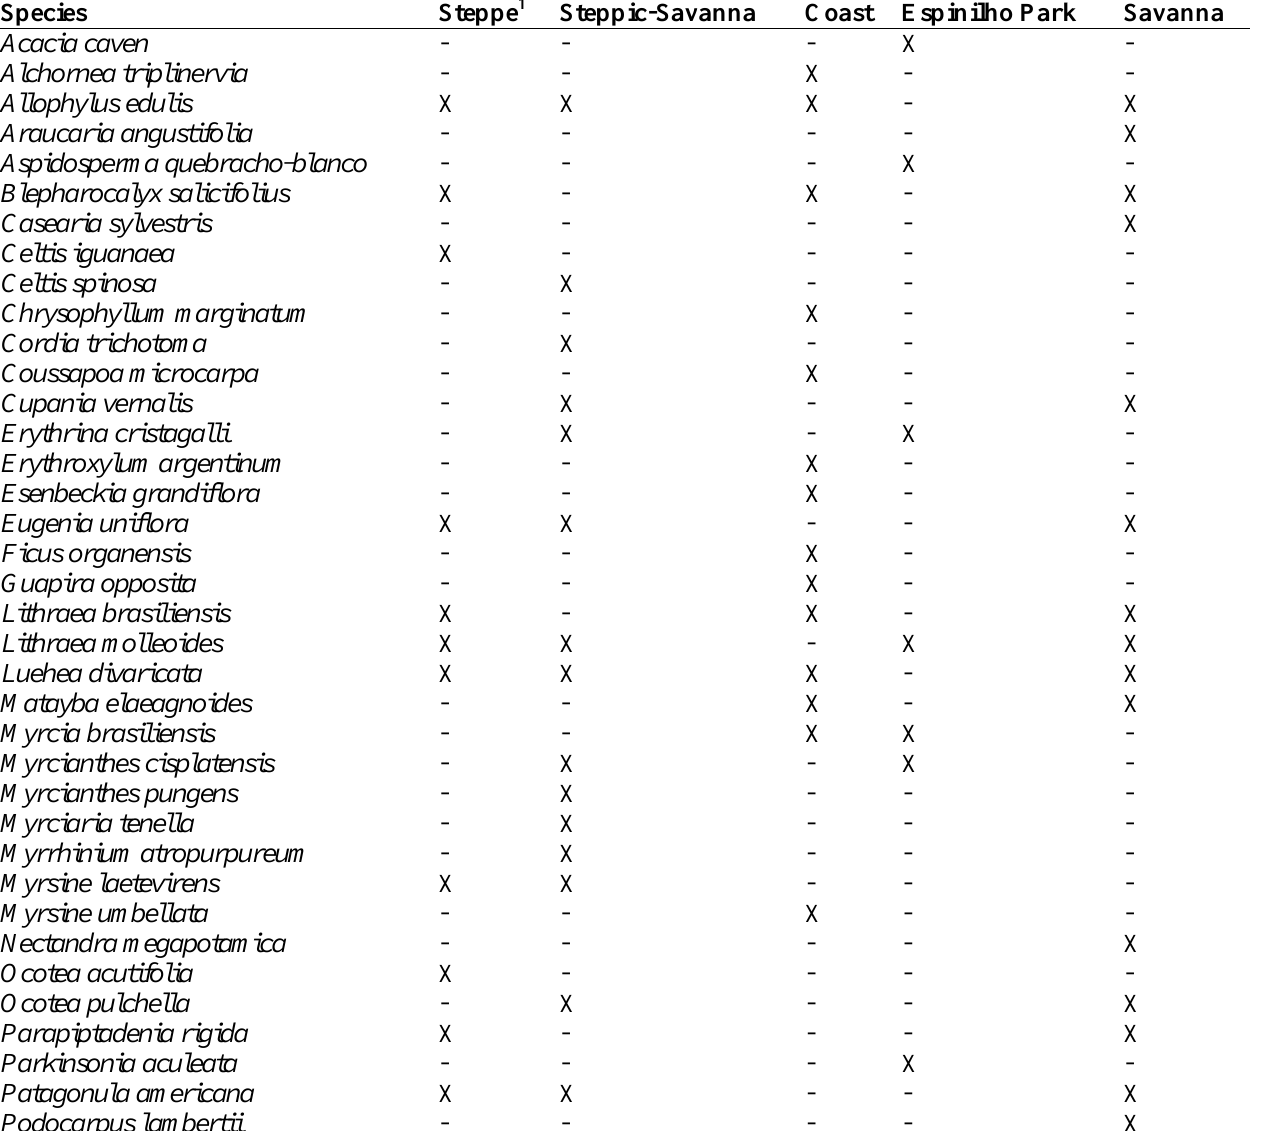
Table 2. Tree species of economic importance ( N = 53) found in the five main environments of the Pampa biome. Adapted from UFSM/SEMA-RS [33]. 1 X = presence of the species; - = absence of the